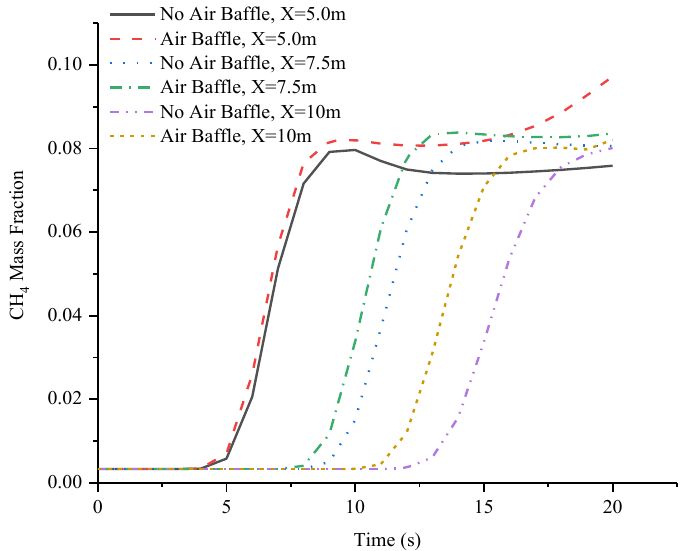
Figure 7. The relationship between CH 4 concentration and time change at monitoring points at different leakage locations.